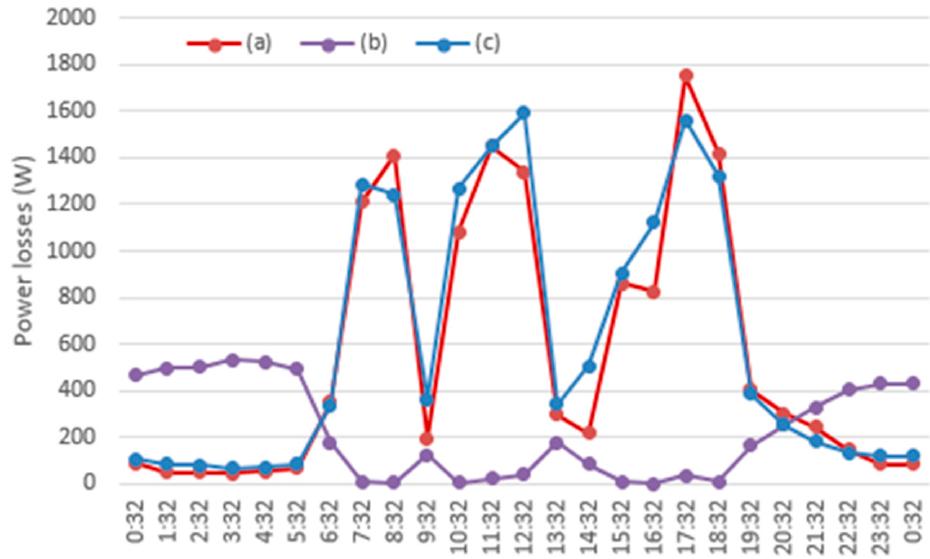
Figure 6. Transformer power losses in working days due to (a) active currents ( P ca ); (b) reactive currents with capacitors ( P (cid:48) cr ); and (c) reactive currents without capacitors ( P cr ).